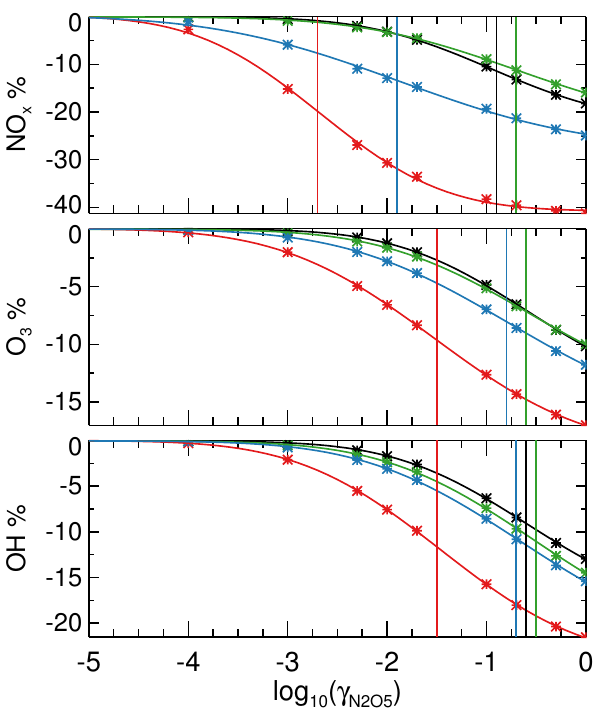
Fig. 2. Impact of γ N on mean annual burdens of NO x , O 3 , and 2 O 5 OH. The curves are plotted using an error function fit to the points, which are taken from the mass weighted annual mean model di- agnostics. Northern extra-tropics (90 ◦ N–30 ◦ N) are in red, tropics (30 ◦ N–30 ◦ S) are in green, southern extra-tropics (30 ◦ S–90 ◦ S) are in black, and global values are shown in blue. The vertical bar indi- cates the point of maximum gradient on the curve (the vertical black bar is not visible on the O 3 plot as it is overlain exactly by the green bar).